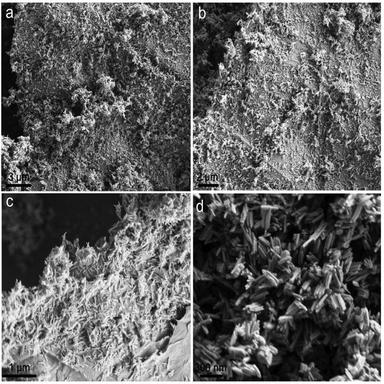
SEM images of SrFe12O19 NR/G-29.7 after 10,000 cycles.